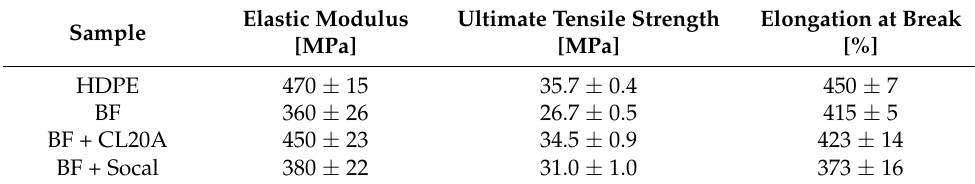
Table 2. Main mechanical properties of the extruded